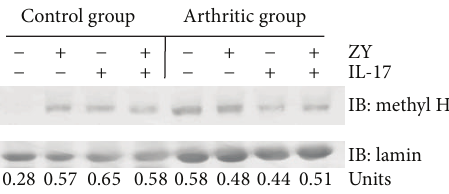
Figure 4: Methylated H3K9 (methyl H3) in nuclear extracts from neutrophils. Ly6G + CD11b + cells were purified and stimulated with (20 𝜇 g/mL) or/and IL-17 (40ng/mL) for 10min. Nuclear extracts were obtained as described in Section 2. Methylated H3K9 in nuclear extracts from neutrophils was detected by immunoblot (IB). Lamin in nuclear extracts was used as a control for protein content. Densitometry analyses of IBs were performed by ImageJ 1.42 software (NIH, Bethesda, MD, USA). The density of methyl H3K9 lines was normalized to lamin expression in each sample and was presented in